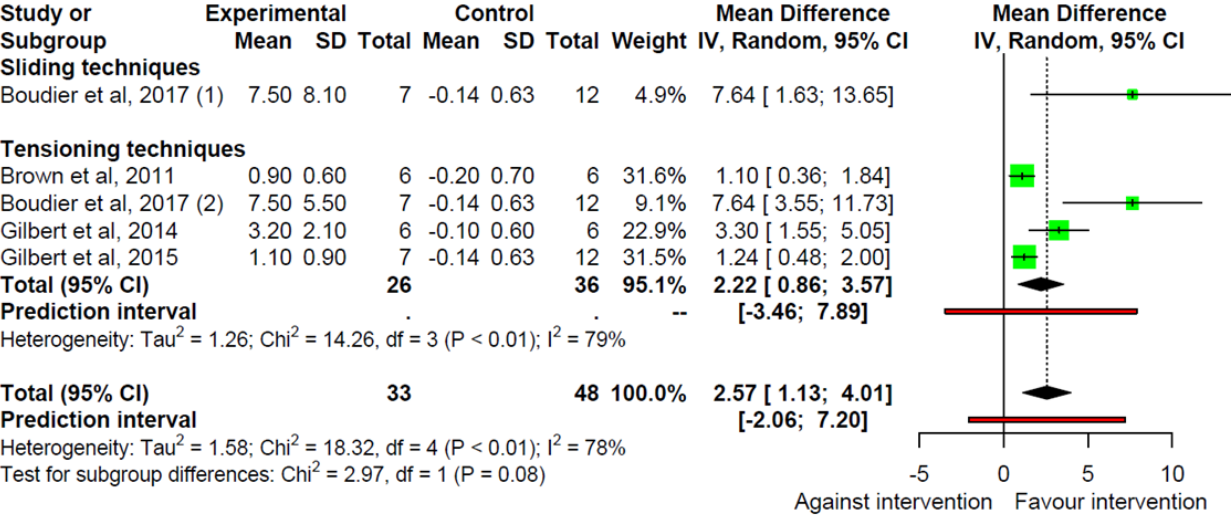
Figure 2. Forest plot showing the mean differences for the fluid dispersion [26 – 29].